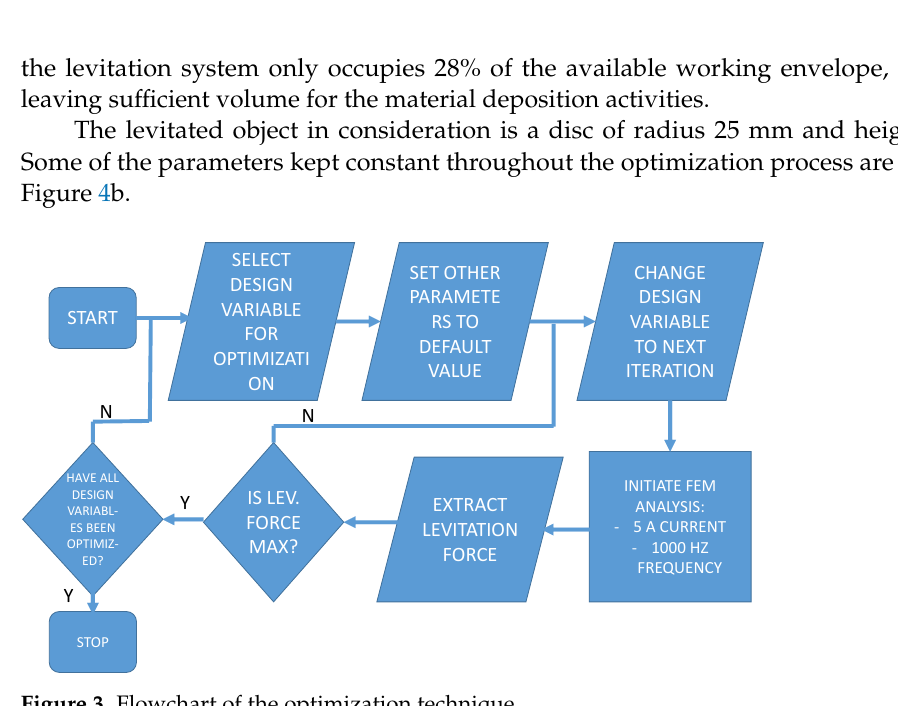
Figure 3. Flowchart of the optimization technique.